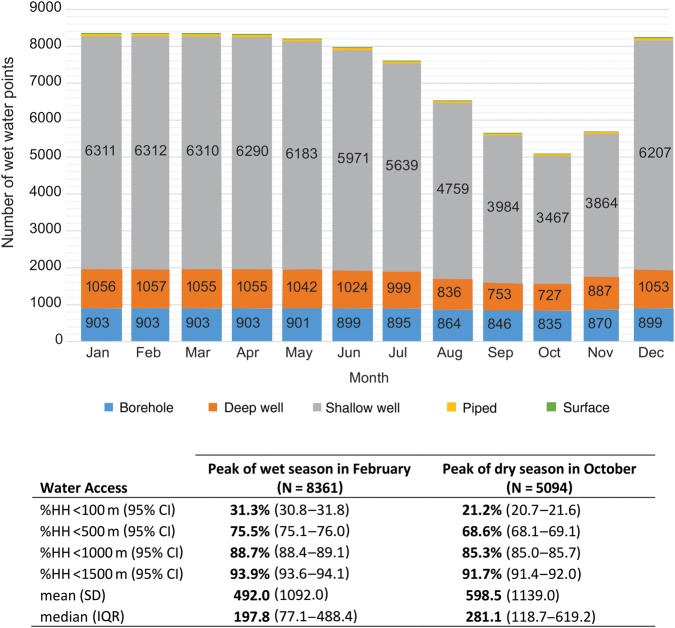
Seasonal variation of available functional water points showing water coverage during the wet and dry seasons. Abbreviations: CI, confidence interval; HH, household; IQR, interquartile range; SD, standard deviation.